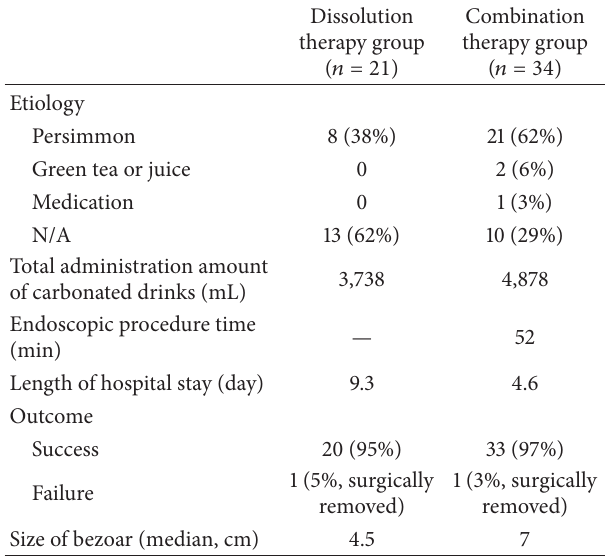
Table 3: Comparison of clinical characteristics between dissolution therapy and combination therapy